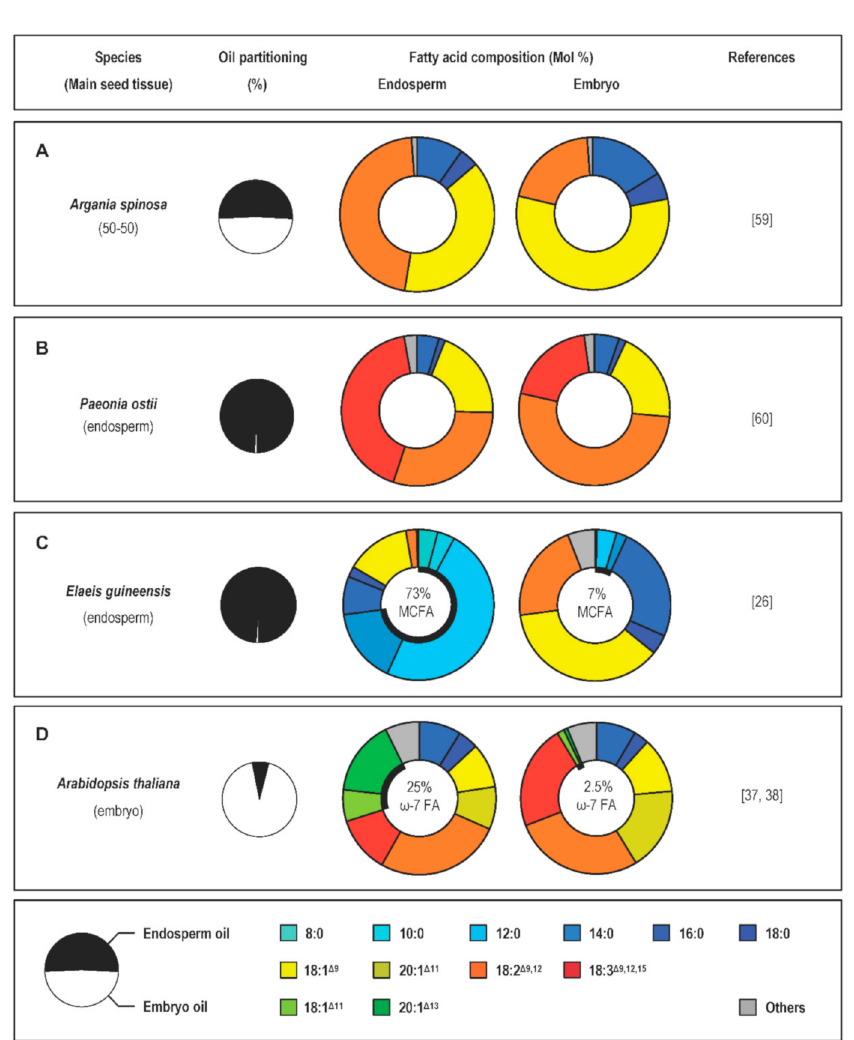
Figure 3. Fatty acid composition of endosperm and embryo oils in seeds of different species. ( A ). Argania spinosa . ( B ). Paeonia ostii . ( C ). Elaeis guineensis . ( D ). Arabidopsis thaliana . For each species considered, a pie chart presents the repartition of seed oil between embryo and endosperm tissues. Circular charts present the relative proportions of the main fatty acid species comprising endosperm and embryo oils, respectively. The relative abundance of unusual fatty acids in each compartment is indicated in the center of the circular charts. FA, fatty acid; MCFA, medium-chain fatty